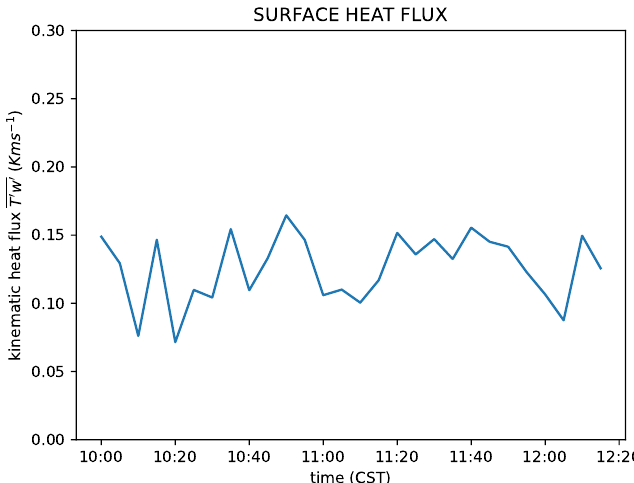
Figure 2. Five-minute averaged kinematic surface heat flux T (cid:48) w (cid:48) derived from 1 Hz wind and temperature sonic anemometer time series of the background ambient environment.